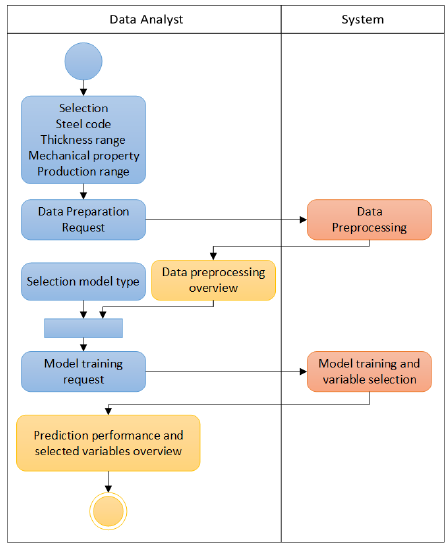
Figure 7. Model identification UML activity diagram.